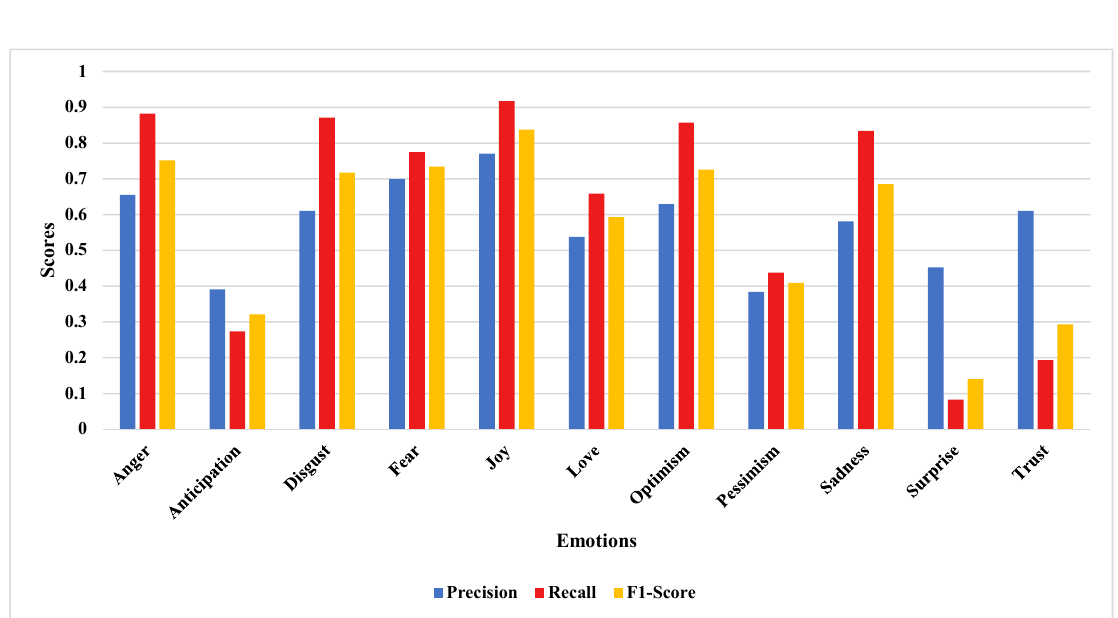
Figure 4. Performance